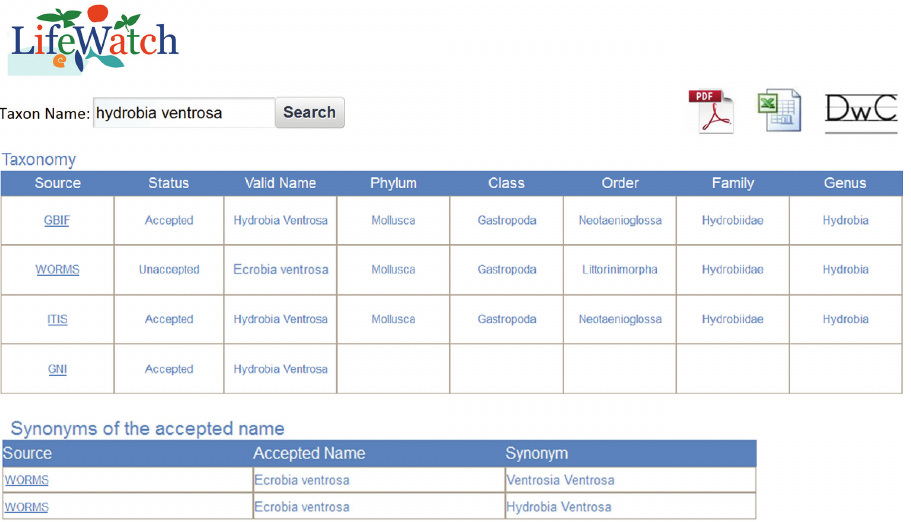
Figure 4. Result of searching Hydrobia Ventrosa using our